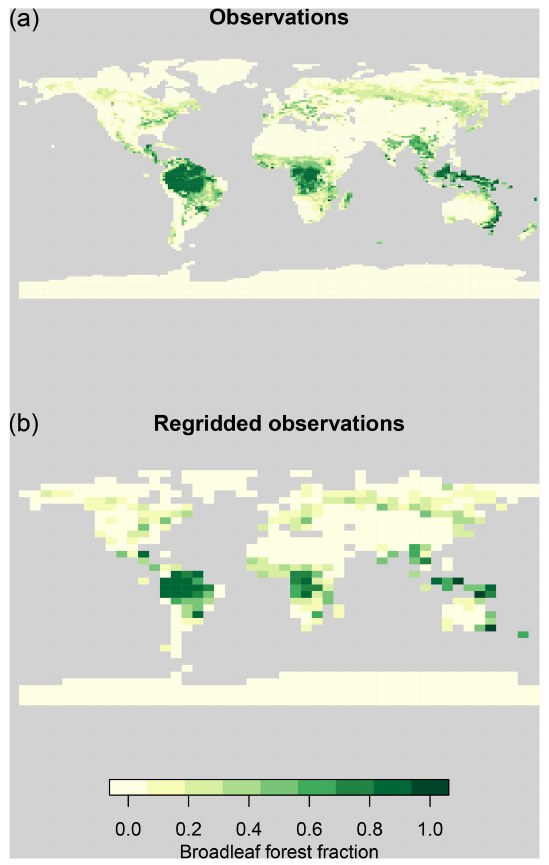
Figure 2. Observations of broadleaf forest fraction on their native grid (a) and regridded to the FAMOUS grid (b) .